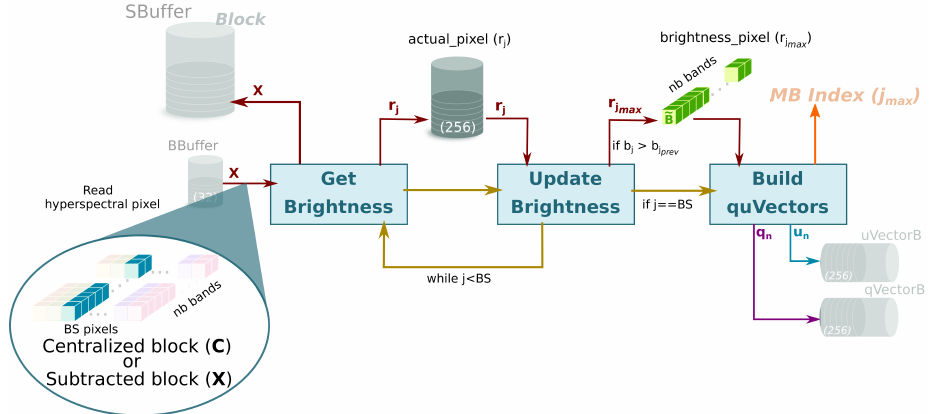
Figure 5. Overview of Brightness